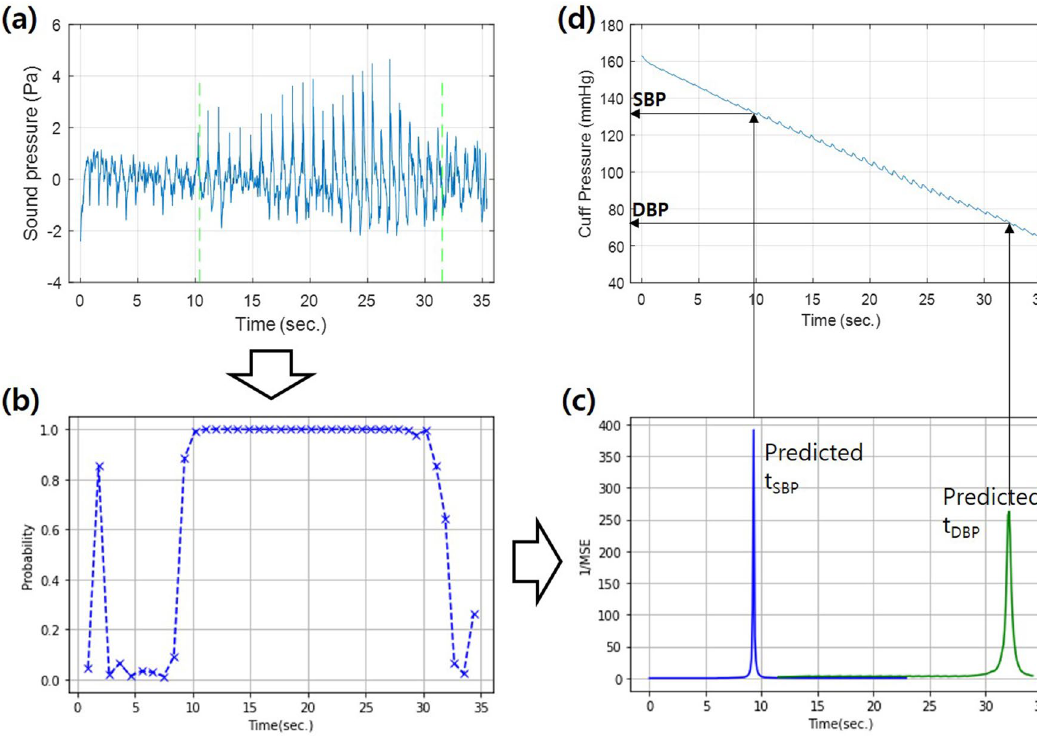
Figure 6. Blood pressure decision: ( a ) sound signal, ( b ) K-sound probability values, ( c ) prediction of t SBP and t DBP , and ( d ) SBP and DBP